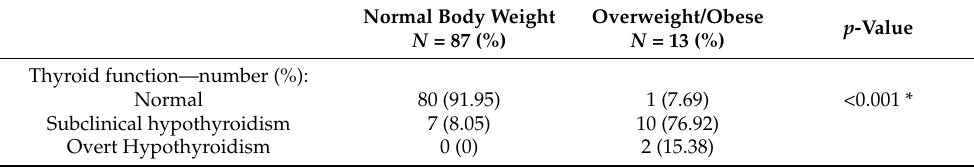
Table 2. Subgroup analysis of migraine cases according to body mass index. Normal Body Weight Thyroid function—number (%): Normal